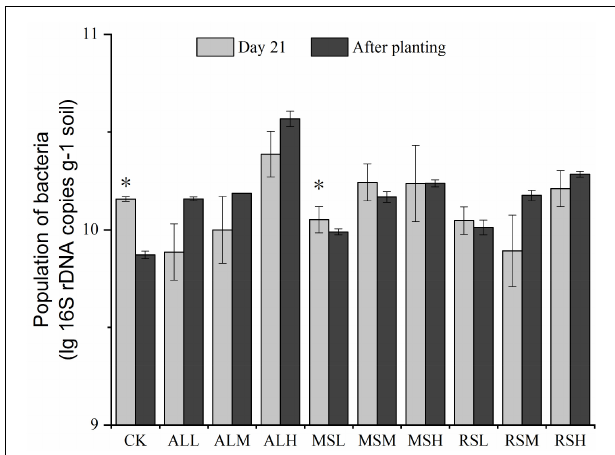
FIGURE 2 | Determination of bacterial populations in samples from the 10 treatments at different time points. Error bars represent standard errors of the means of three replicates. ∗ P <